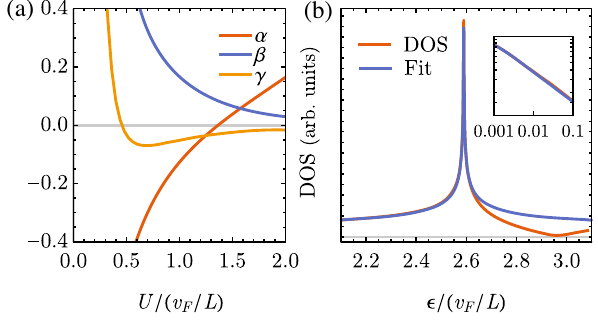
v L n − 1 n ! Þ − 1 FIG. 2. (a) Dimensionless derivatives ∂ n E= ∂ p n F x ð of the moir´e surface state dispersion with respect to momentum at the K point, where α , β , and γ correspond to n ¼ 2 , 3, and 4 [see Eq. (5) of main text]. The potential is given in Eq. (4). When 1 . 36 , α vanishes, making the K point a high-order UL=v F ¼ saddle point. (b) DOS around the high-order VHS. The log-log plot in the inset shows that the divergence of the DOS is indeed power law. The fitting is given by N ð ϵ Þ ¼ c j ϵ − ϵ 0 j ν , where c ¼ 0 . 76 , ϵ 0 ¼ 2 . 59 , and ν ¼ − 0 . 39 . ν ¼ − 0 . 39 agrees well with theoretical result ν ¼ − 1 = 3 (see main text).